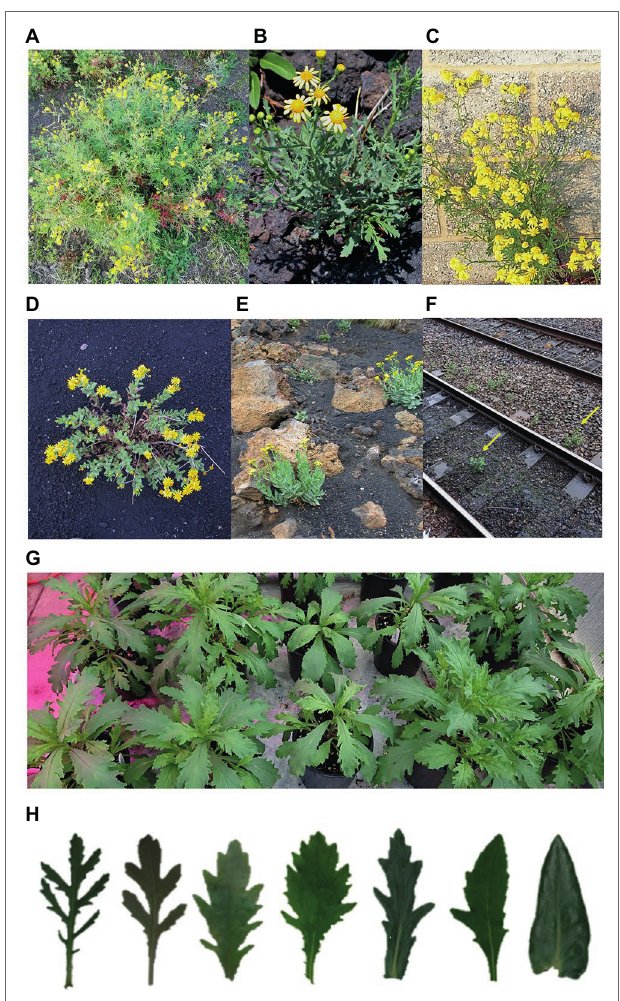
FIGURE 1 | Examples of phenotypes and habitats of Senecio aethnensis , Senecio chrysanthemifolius , their natural hybrids and Senecio squalidus . (A) S. chrysanthemifolius from Mount Etna. (B) Natural hybrid on Mount Etna. (C) Homoploid hybrid species S. squalidus from Oxford, United Kingdom. (D) S. aethnensis from Mount Etna. (E) Natural habitat of Senecio on Mount Etna. (F) S. squalidus found on railways in the United Kingdom (identified by yellow arrows). (G) Variation in leaf phenotypes in one F 2 synthetic hybrid (between S. aethnensis and S. chrysanthemifolius ) family. (H) Leaf shape variation in greenhouse-grown Senecio . Left most: S. chrysanthemifolius ; Right most: S. aethnensis ; All in-between: synthetic F 2